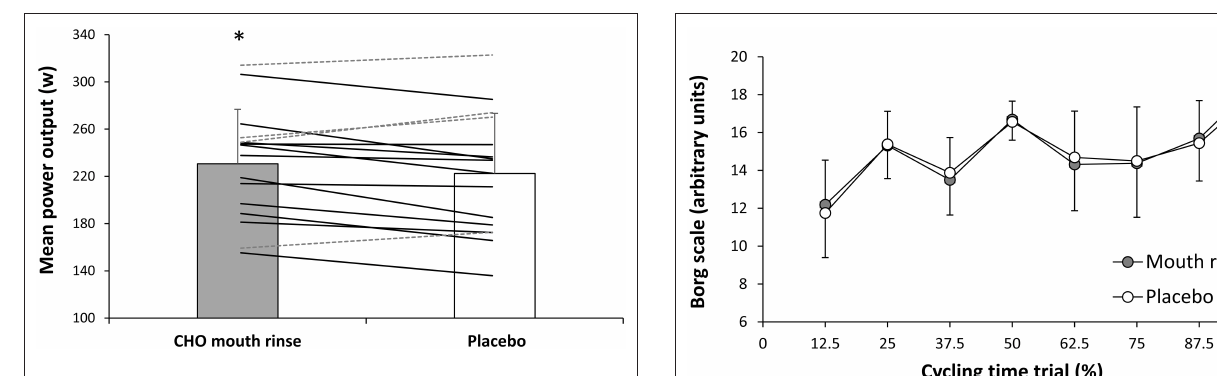
FIGURE 3 | Mean power output during the cycling time trial with carbohydrate mouth rinsing or with placebo mouth rinsing. Solid lines represent participants with higher power output in the carbohydrate mouth rinsing protocol vs. placebo. Dashed lines represent participants with lower power output in the carbohydrate mouth rinsing protocol vs. placebo. *Different from placebo at P < 0.05.